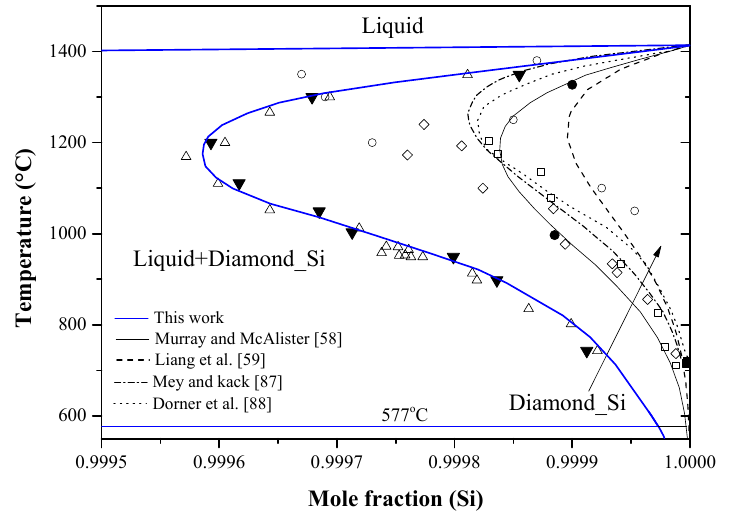
Figure 5. Magnified part of the Si-rich side of the Al-Si phase diagram; ― : [58]; -----: [59]; -·-·-: [87]; ····: [88]; ■ : [29]; ● : [65]; □ : [68]; ○ : [69]; Δ (EPMA): [70], ▼ (Hall measurements): [70]; ♦ : [89].